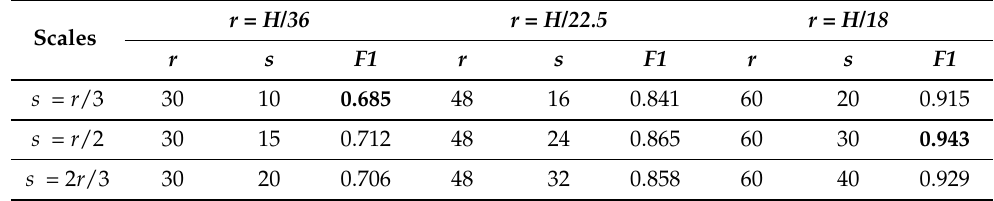
Table 3. Quantitative comparisons on F 1- score by setting ten different scales of WLpeephole, respec- tively (here, H denotes the height of an image, λ = 10 pixels, the bold refers the best result). r = H/36 r = H/22.5 r = H/18 Scales r s F1 r s F1 r s F1 s = r /3 30 10 0.685 48 16 0.841 60 20 0.915 s = r /2 30 15 0.712 48 24 0.865 60 30 0.943 s = 2 r /3 30 20 0.706 48 32 0.858 60 40